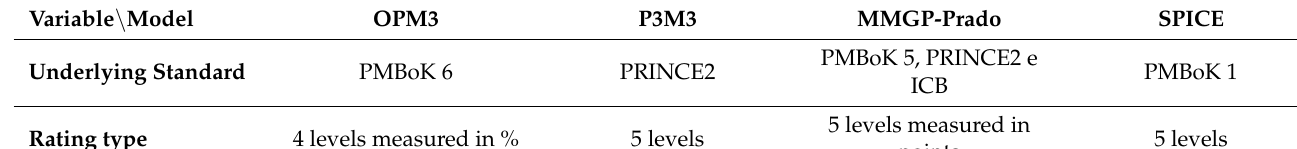
Table A2. Comparison table of identified maturity models applied to construction.